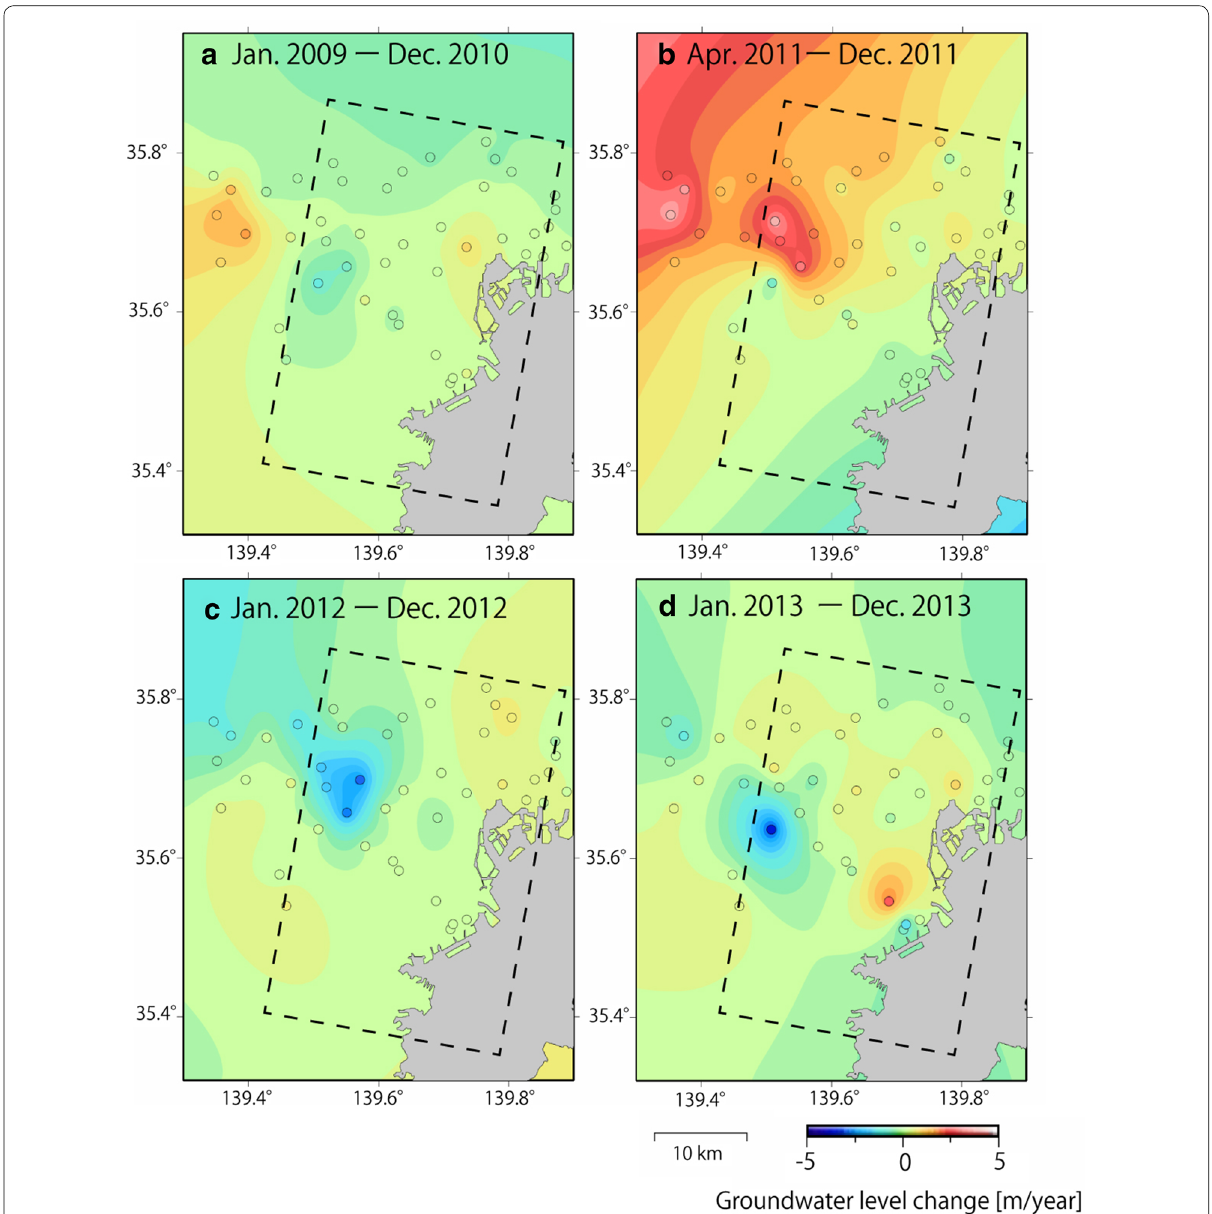
December 2012, and d January 2013–December 2013. Positive values indicate increases in groundwater level. Circles and dots are groundwater well locations and GPS locations, respectively. Black dashed lines are TerraSAR-X data coverage used in Fig.